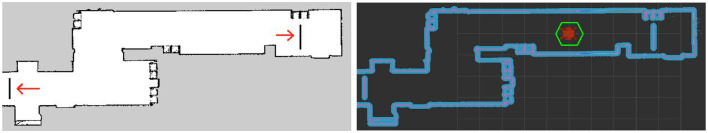
Left: A static map of a corridor. The red arrow points at a synthetic barrier manually added to the map. Right: A costmap of 10 cm in blue surrounds all static barriers. The green hexagonal shape is a synthetic barrier around the QUICKIE base used for collision avoidance.